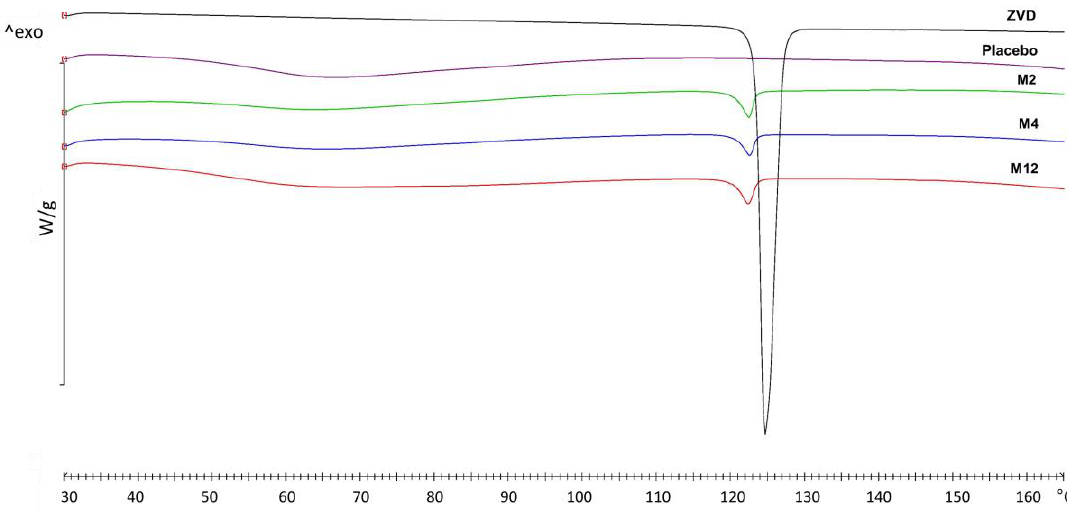
Figure 7. Thermograms of pure zidovudine (ZVD), placebo microparticles with chitosan glutamate crosslinked with beta-glycerophospahe (gCS:CF 2:1), and selected drug-loaded formulations differed in the crosslinking ratio gCS:CF (M2 (2:1); M4 (3:1); M12 (1:1), w / w